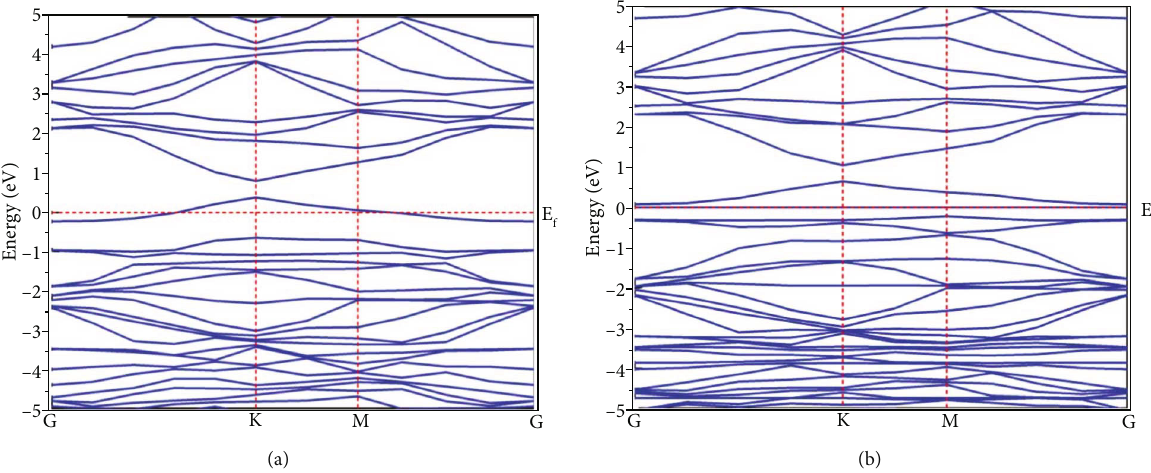
Figure 7: The band structure of Al-Graphene and NF